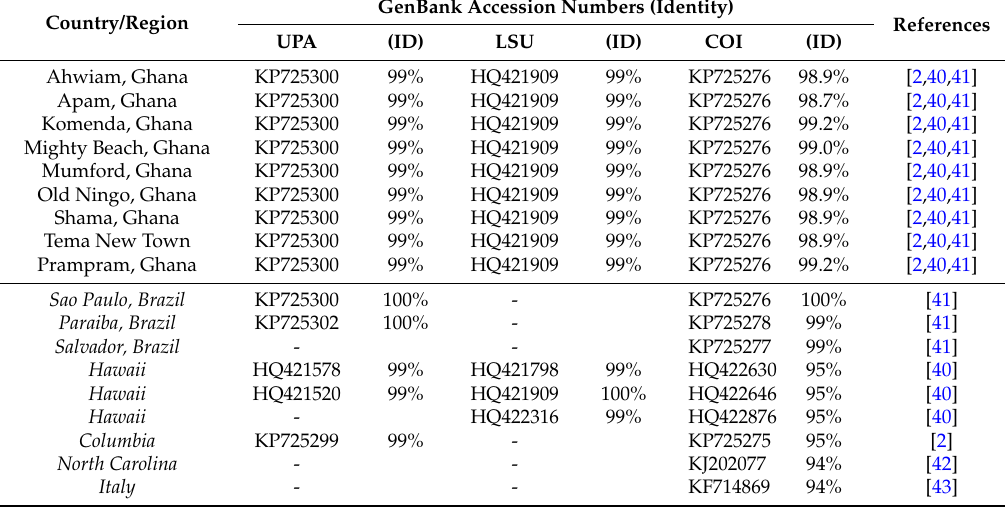
Table 1. Barcode alignment for nine morphologically-identified Hypnea sp. collected in different coastal sites of Ghana. The best matches for the individual markers (UPA, LSU, and COI) are noted with their GenBank accession numbers, and the publisher of the sequence. The accession numbers in italic text are the reference H. musciformis sequences from locations around the world. The individual barcode sequences were pairwise aligned (BLAST) using the closest match of the reference sequence ( H. musciformis UPA: KP725300; LSU: HQ421909; COI: